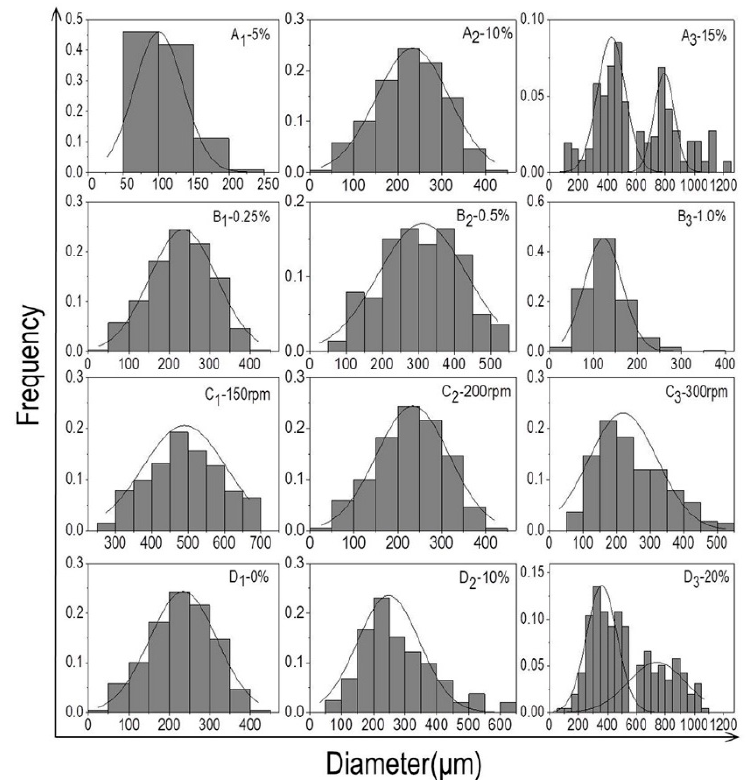
Figure 1. ( A 1 – A 3 ) Histograms of particle size distribution of PLLA microcarriers prepared with different concentrations of PLLA ( A 1 – A 3 : 5%, 10%, 15%; the gelatin concentration was fixed at 0.25% and the stirring speed at 200 rpm); ( B 1 – B 3 ) histograms of the particle size distribution of PLLA